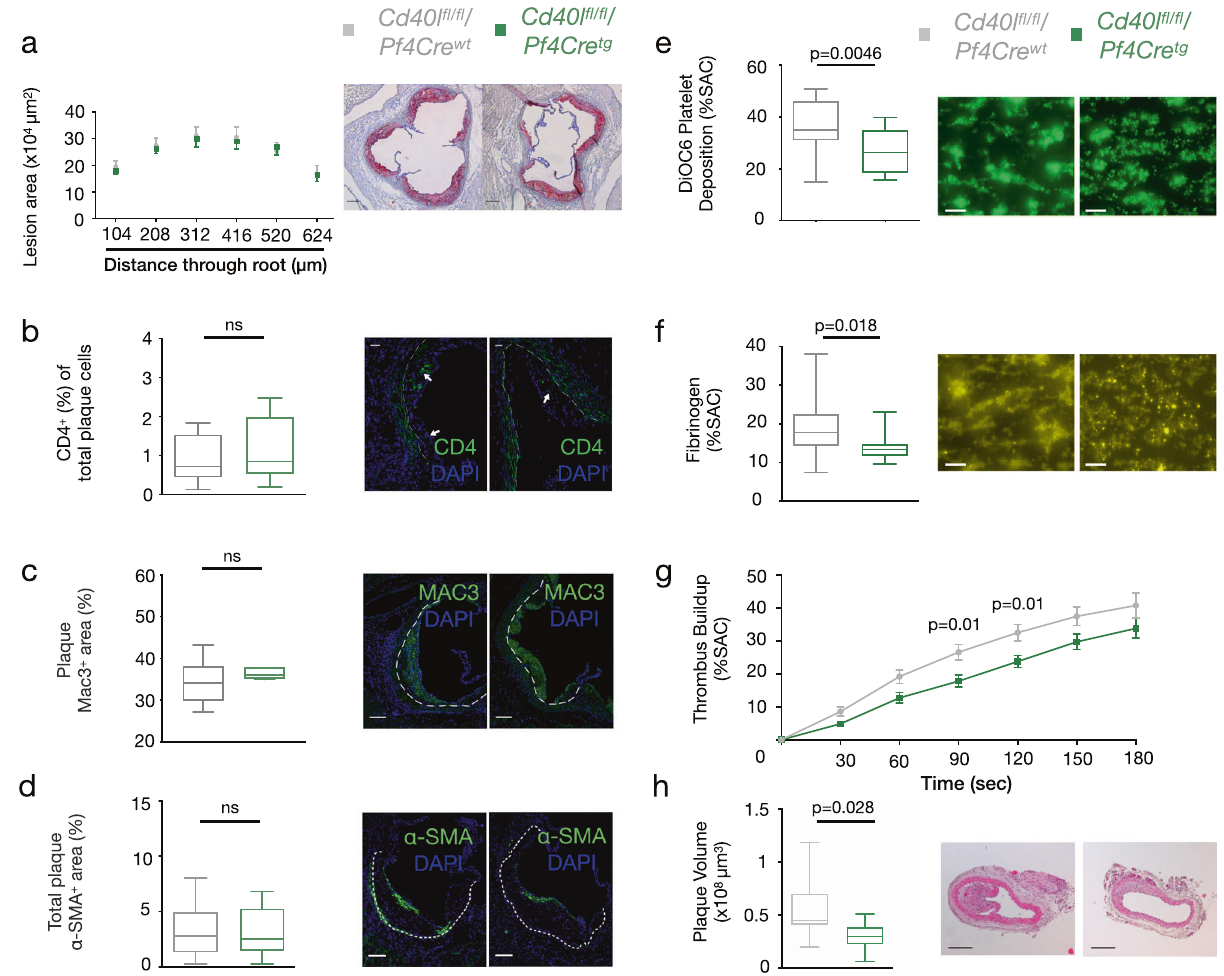
Fig. 2 Platelet CD40L de fi ciency alters thrombosis formation and atherothrombosis. a Atherosclerotic plaque area in cross-sections at indicated positions of the aortic root from Cd40l fl / fl /Pf4Cre mice [ n : WT = 21, TG = 18] with representative Oil Red O-stained photomicrographs (scale 200 µ m). b – d Immuno fl uorescent staining assessing plaque phenotypes in cross-sections of the aortic root of mice with quanti fi cations (left) and representative photomicrographs (right). Arrows indicate stained cells and the dashed line separates the atherosclerotic lesion. b CD4 + T cells (green) along with nuclear DAPI staining (blue) [ n : WT = 10, TG = 8], ( c ) Mac3 + area (green) along with nuclear DAPI staining (blue) [ n : WT = 6, TG = 5], and ( d ) Alpha-smooth muscle actin + ( α -SMA + ) area [ n : WT = 18, TG = 15] (green, scale bar: 75 µ m). e – f Multi-parameter assessment of thrombus formation in fl owed whole blood with CD40L de fi cient platelets with quanti fi cations (left) and representative photomicrographs (right, scale bar: 20 µ m). Parameters evaluated after 4 min of blood fl ow were: e 3,3 ′ -Dihexyloxacarbocyanine iodide (DiOC6) labelled platelet adhesion (Surface Area Coverage, SAC%) [ n : WT = 19, TG = 12] and ( f ) Fluorescein isothiocyanate (FITC)-labelled fi brinogen staining of thrombi [ n : WT = 20, TG = 12]. g Thrombus build-up [ n : WT = 20, KO = 12] was analyzed using micro-spot perfusions comparing Cd40l fl / fl /Pf4Cre tg mice and their littermate controls. h Plaque volume [ n = 8] was measured in the carotid arteries following wire injury with quanti fi cations (left) and representative photomicrographs (right, scale bar: 200 µ m). Data are represented as either mean ± s.e.m. ( a , g ) or boxplots ( b – f , h ). In the boxplots, whiskers above and below the boxes indicate the 10th and 90th percentile while the boundaries of the boxes represent the 25th and 75th percentile. The black line within the boxes marks the median. n refers to biologically independent animals. Data were analyzed by either a two-tailed unpaired Student ’ s t test ( a , e , g ) or two-tailed Mann – Whitney test ( b – d , f , h ). Source data are provided as a Source Data fi